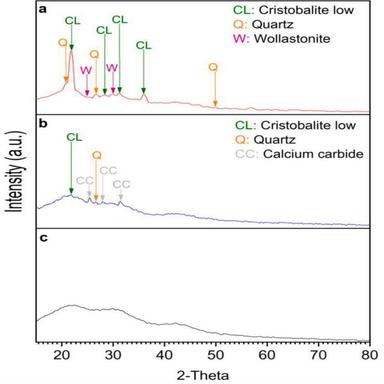
XRD of silica samples from SCB (a), CS (b), RH (c).